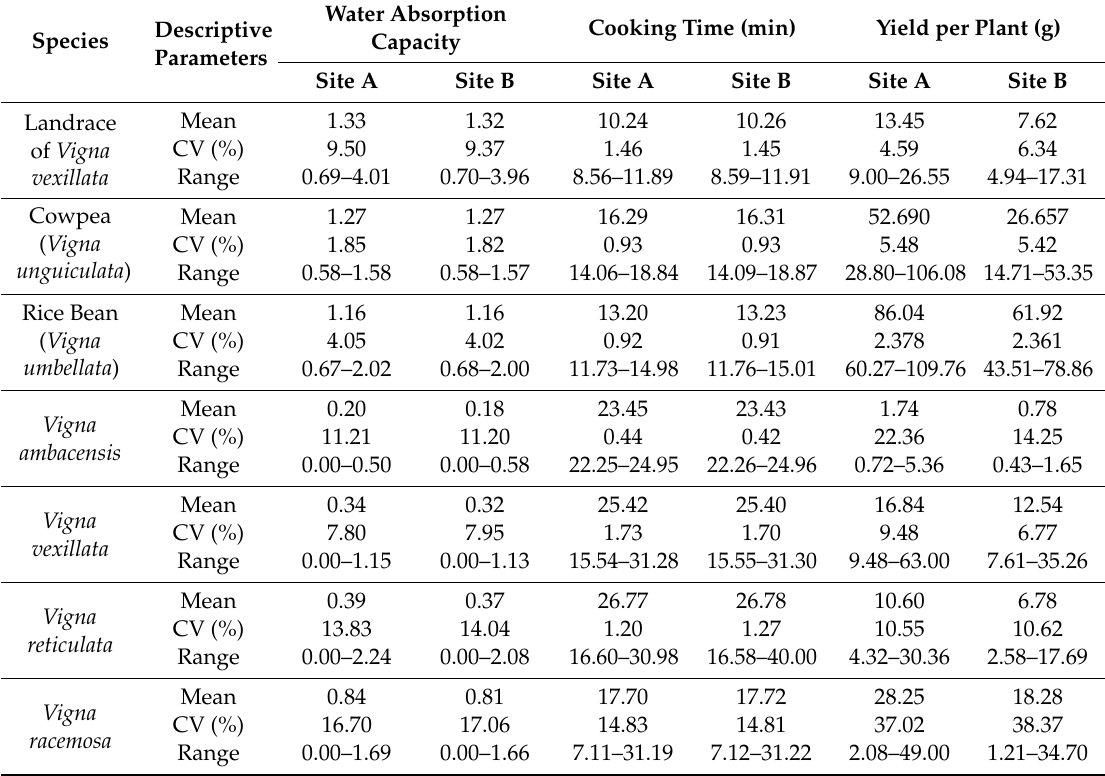
Table 8. Descriptive statistic and yield traits of the wild Vigna